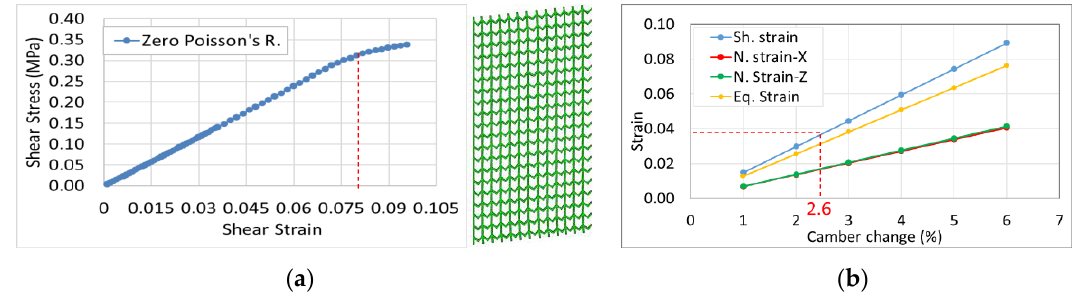
Figure 15. ( a ) In-plane shear stress/strain curve and ( b ) percentage of camber change vs. corresponding strain.